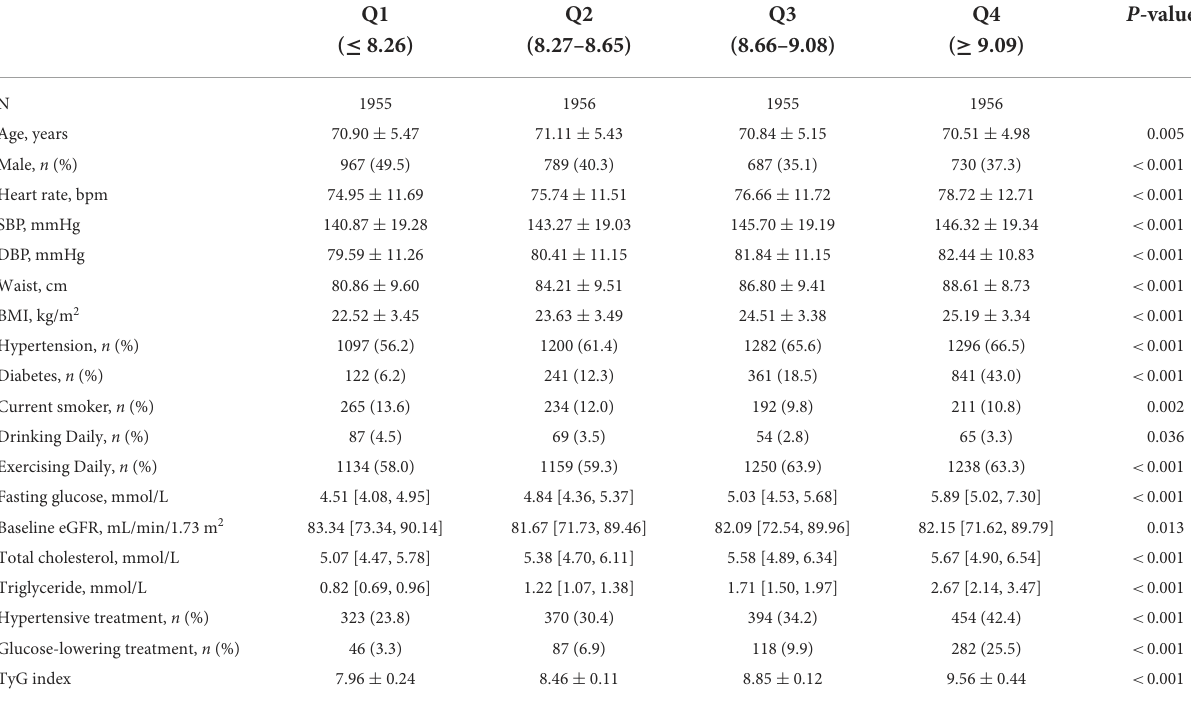
TABLE 1 Baseline characteristics of study participants stratified by triglyceride-glucose index